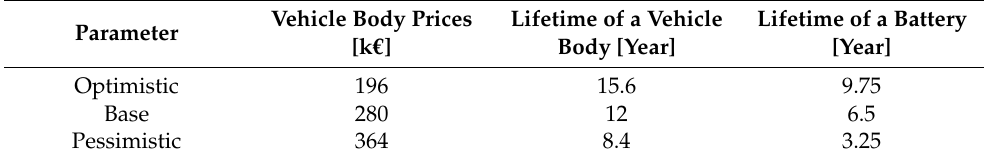
Table 14. Sensitivity analysis of price and lifetime of bus and battery based on the result of pantograph model in